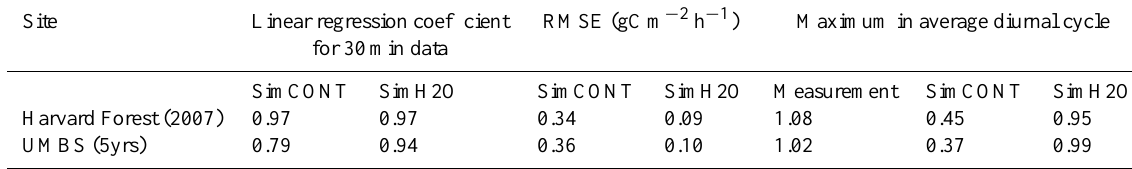
Table 8. Statistical performance of model simulated GPP average diurnal cycles at 2 temperate sites.